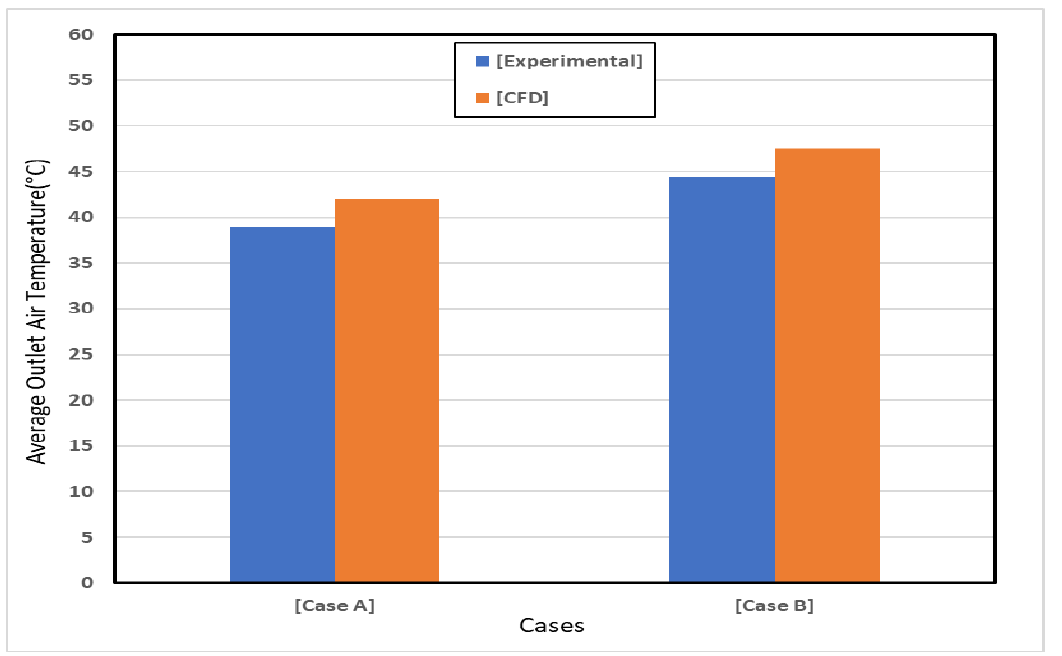
Figure 21. Simulated and experimental average outlet air temperature during the experimental period for the tested Case A and Case B FPSAHs.